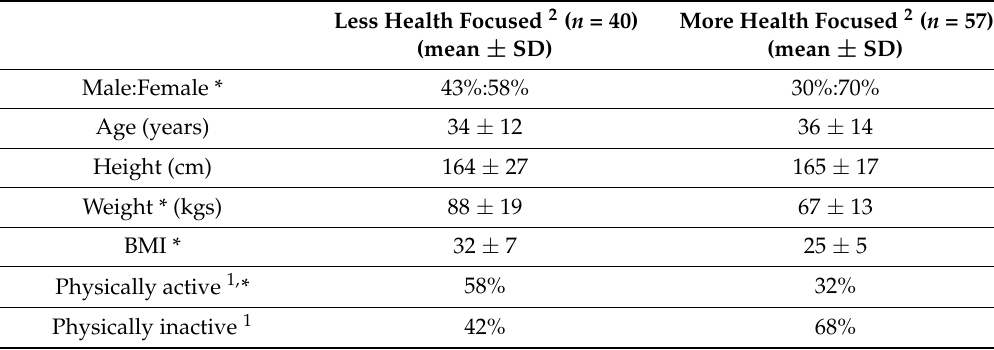
Table 3. Descriptive statistics of